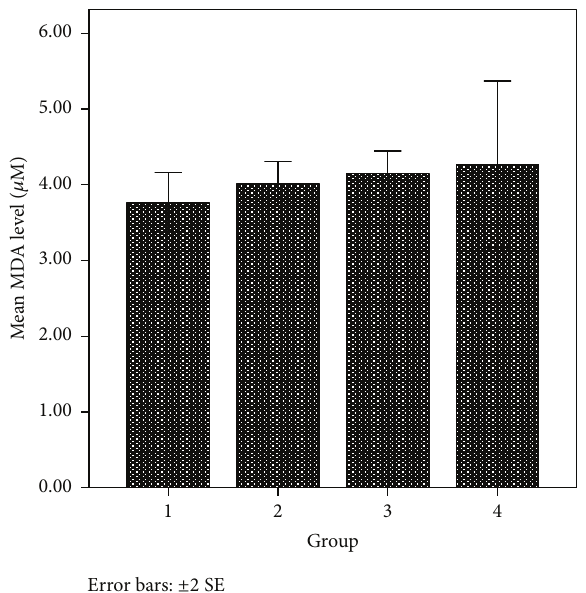
Figure 5: Malondialdehyde (MDA) level in various animal